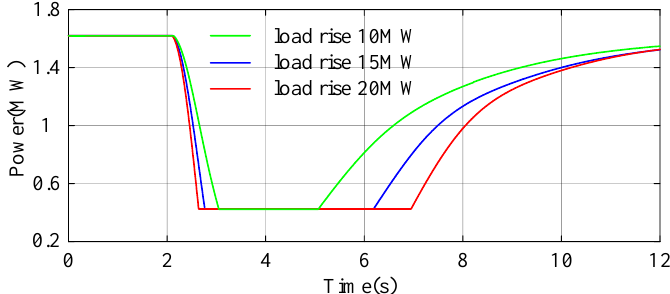
Figure 16. Operation curve of P2H at low wind speed.